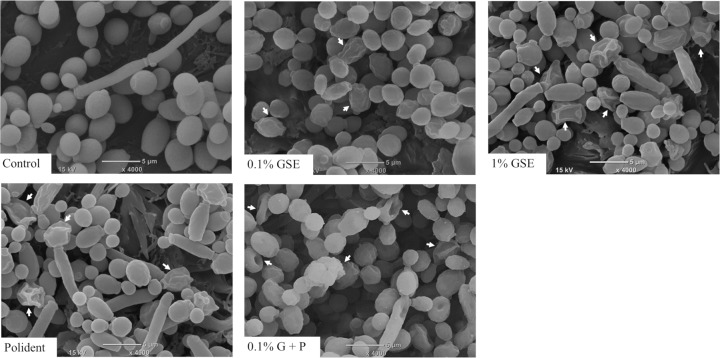
SEM images of the yeast forms inside C. albicans biofilms formed on representative denture-base resin disc surfaces from each group.White arrows indicate cell body shrinkage and deep craters on cell surfaces, which are not seen in the control.